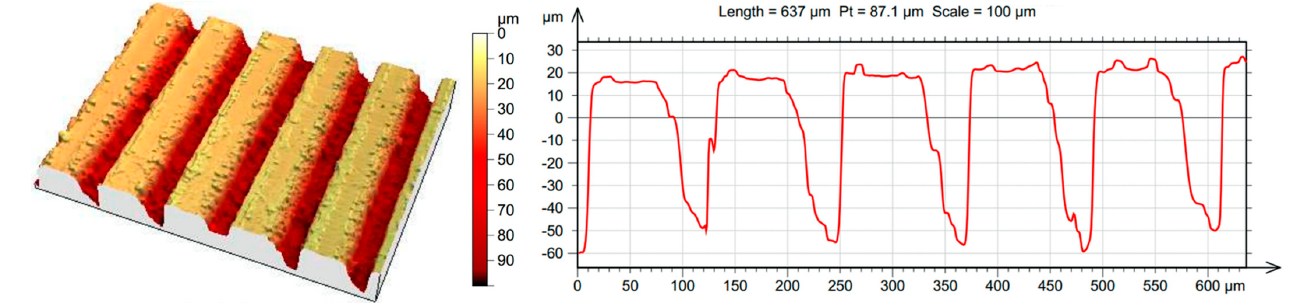
Figure 3. Microscopic image of the cavity’s surface with the designed microstructure dimensions.